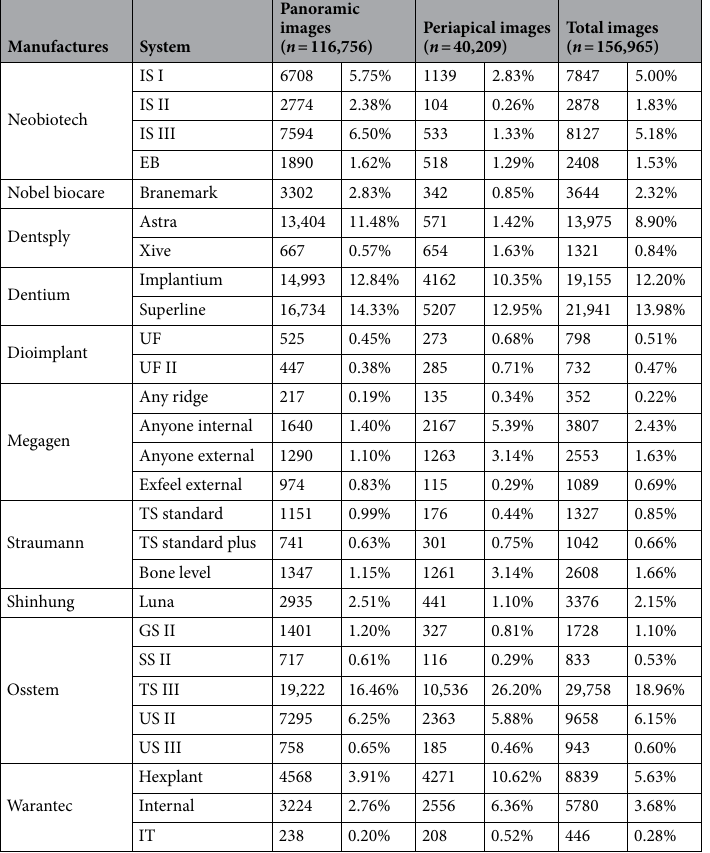
Table 2. Number of panoramic and periapical radiographic images for each dental implant system.